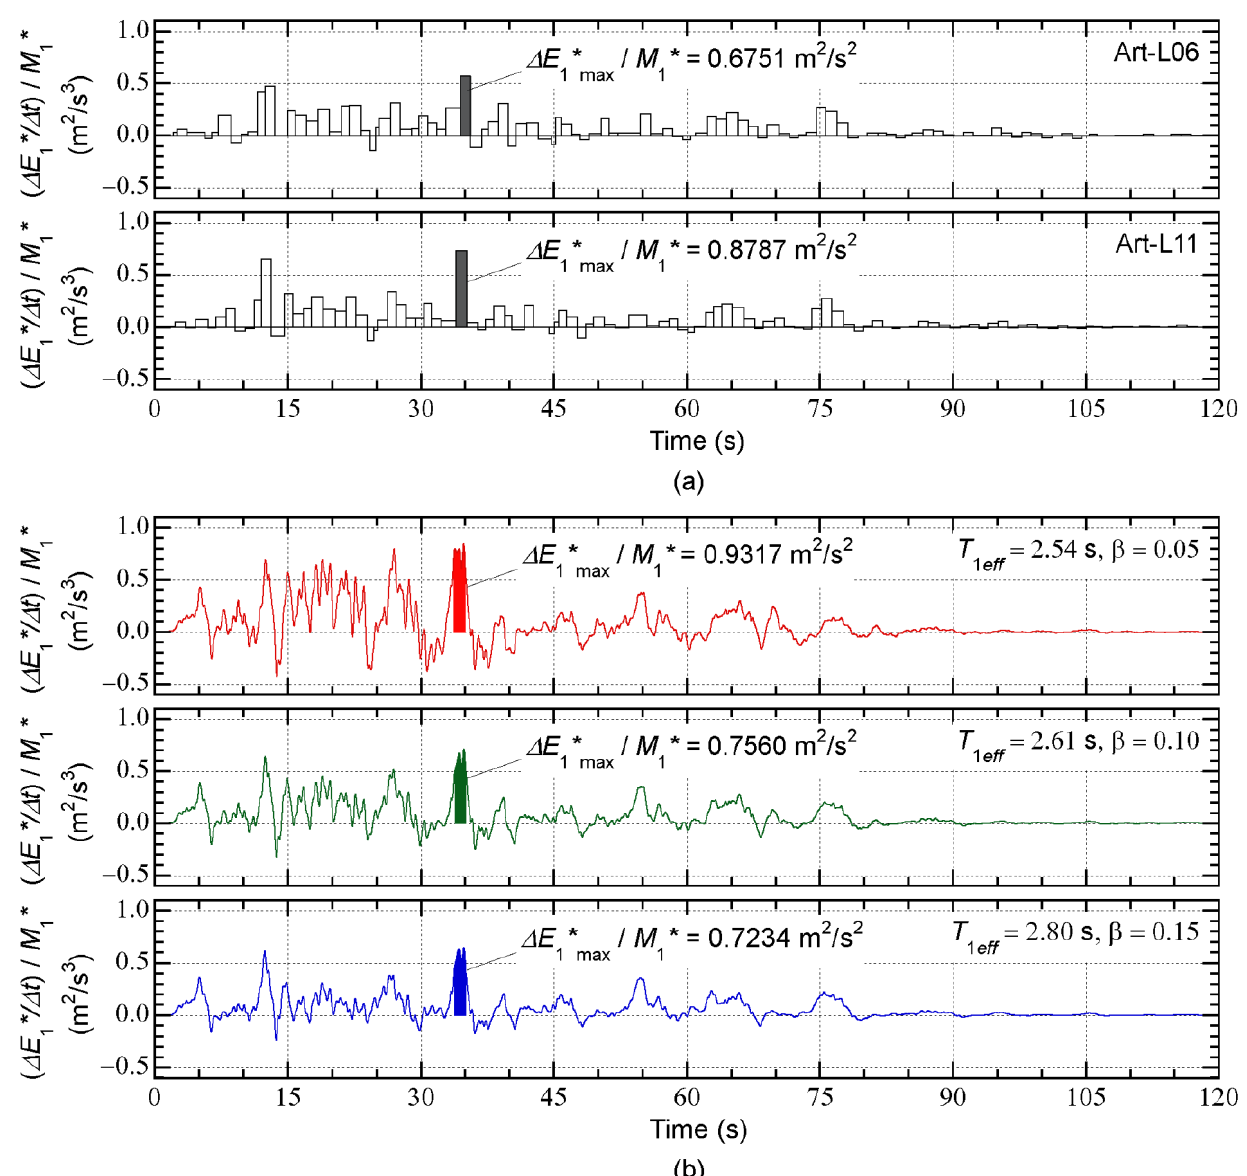
Figure 17. Comparisons of the time-history of the momentary energy input of the first modal response (16-story model, Art-L): ( a ) momentary energy input obtained from the time-history analysis; ( b ) momentary energy input calculated using time-varying function.